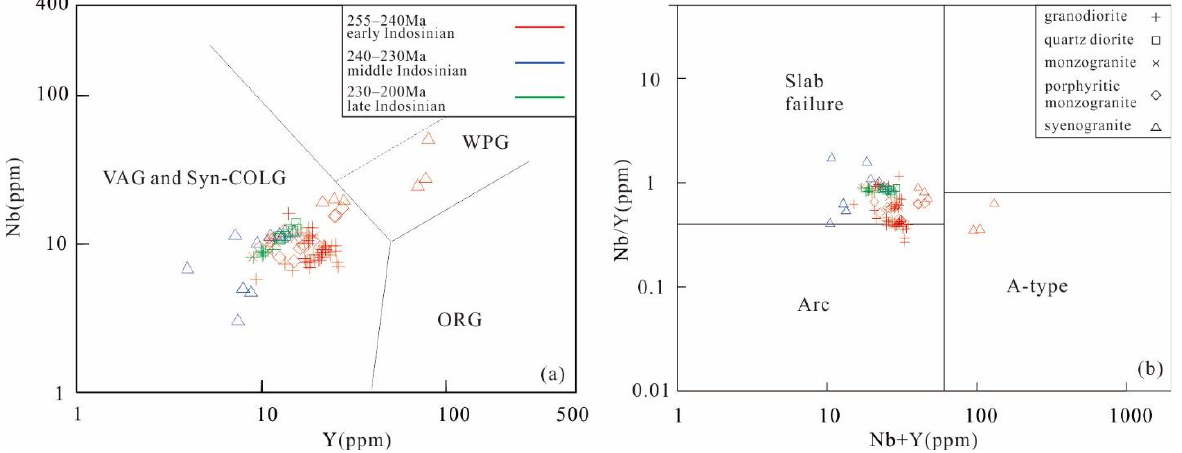
Figure 12. Diagrams of the tectonic setting for the Indosinian granite in the eastern region of the EKO ( a , after [92,93]; b , after [94]). WPG = within plate granites; VAG = volcanic arc granites; ORG = ocean ridge granite; syn – COLG = syn – collision granite.